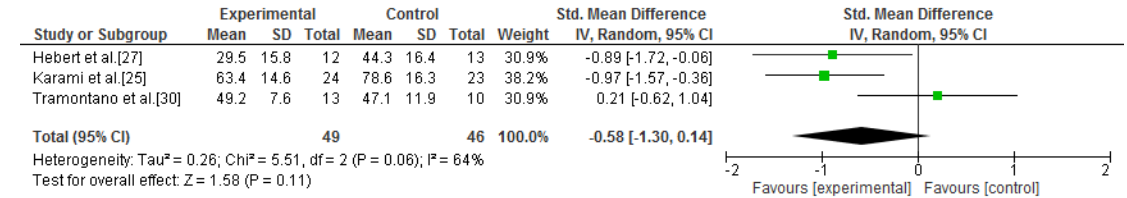
Figure 6. Forest plot of the meta-analysis of fatigue (vestibular rehabilitation versus no intervention).